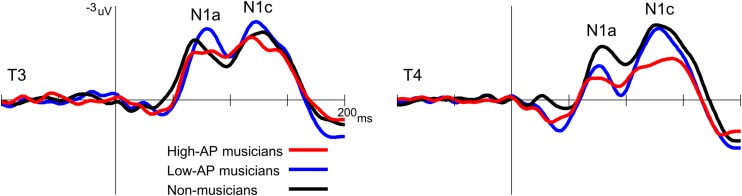
Group comparison of the T-complex amplitudes over the left (T3) and right (T4) hemispheres. At T4, the N1c was significantly smaller in the high-AP musicians than in the low-AP musicians or in the non-musicians.